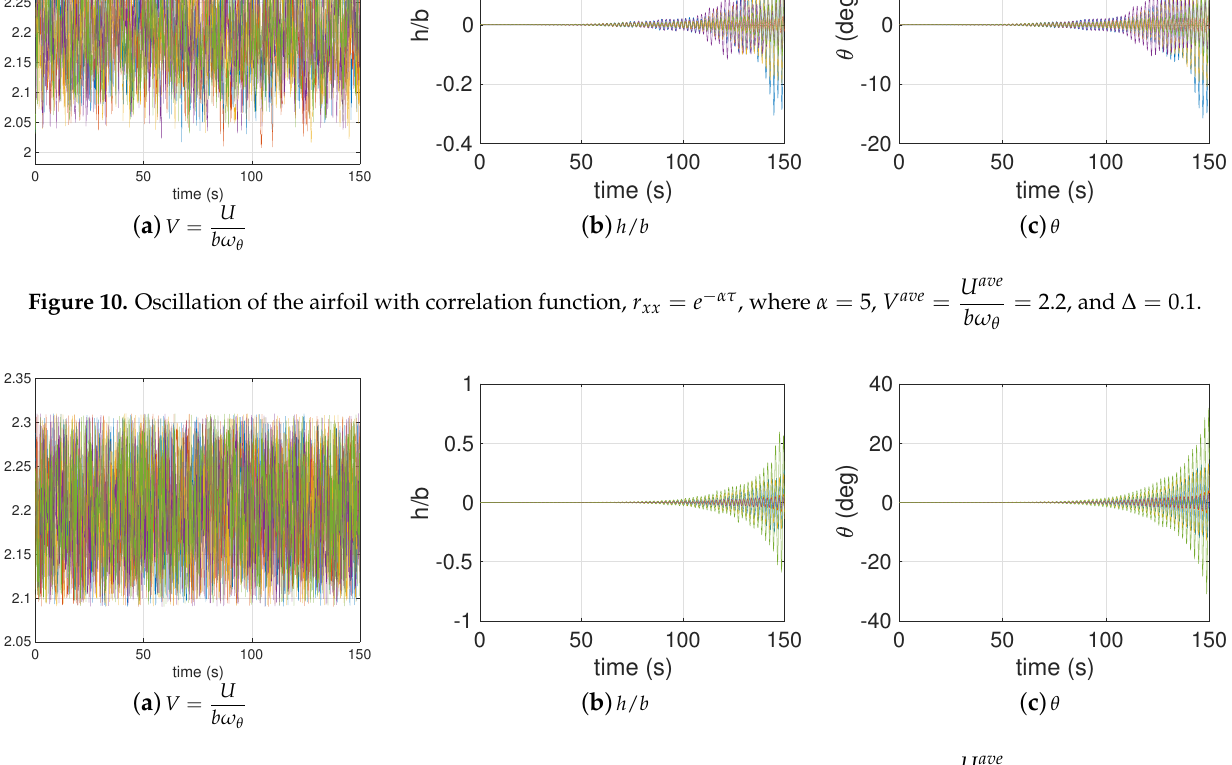
Figure 11. Oscillation of the airfoil with correlation function, r xx = e − ατ , where α = 50, V ave =